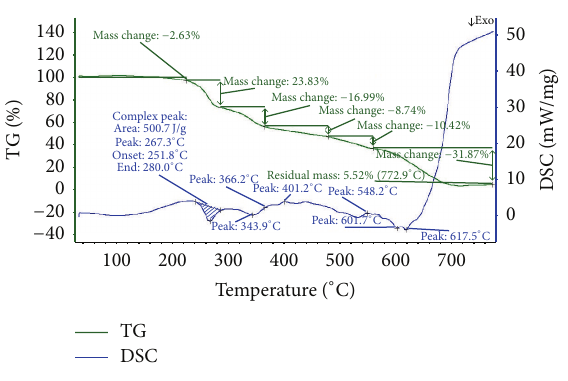
Figure 5: TGA and DSC